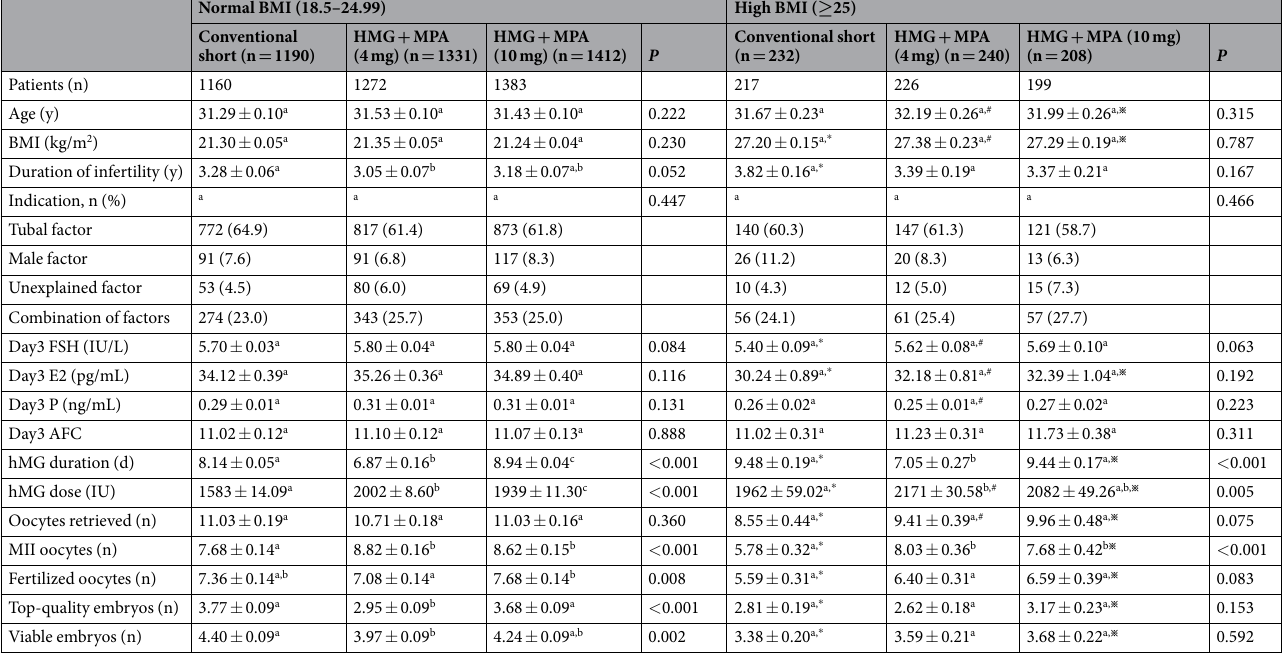
Table 2. Cycle’s characteristics and oocytes outcomes in the three ovarian stimulation groups according to female BMIs. One-way ANOVA analysis, the nonparametric test, student’s t -tests or Mann-Whitney U -test were applied. Data are presented as mean ± standard error of the mean. The differences were considered statistically significant when the p-value was less than 0.05. When compared with the p-value of subgroups in the same BMI group, the different superscript alphabets of a, b, c stand for a significant difference ( p < 0.05). When compared with the p-value of the normal BMI group and high BMI group in the same ovary stimulation group, the symbols * , # , ※ separately stands for a significant difference ( p < 0.05) in the conventional short, HMG + MPA (4 mg) and HMG + MPA (10 mg) ovary stimulation